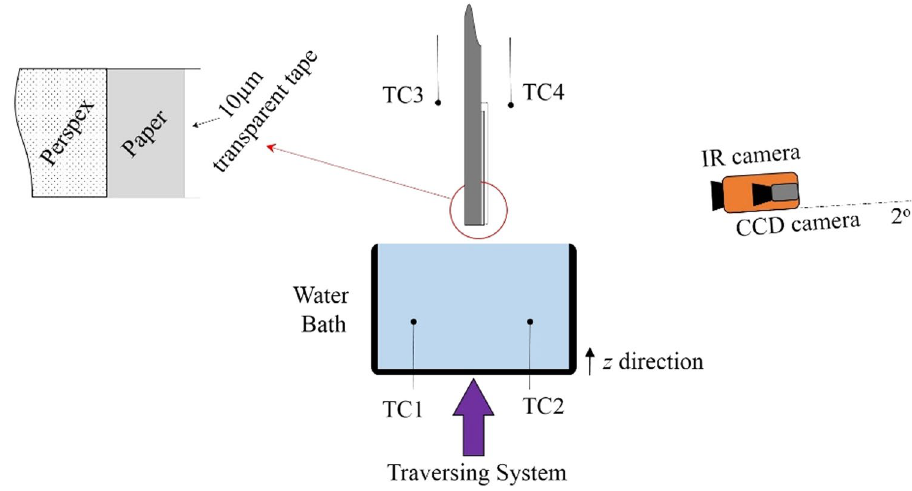
Figure 14. Schematic of the experimental